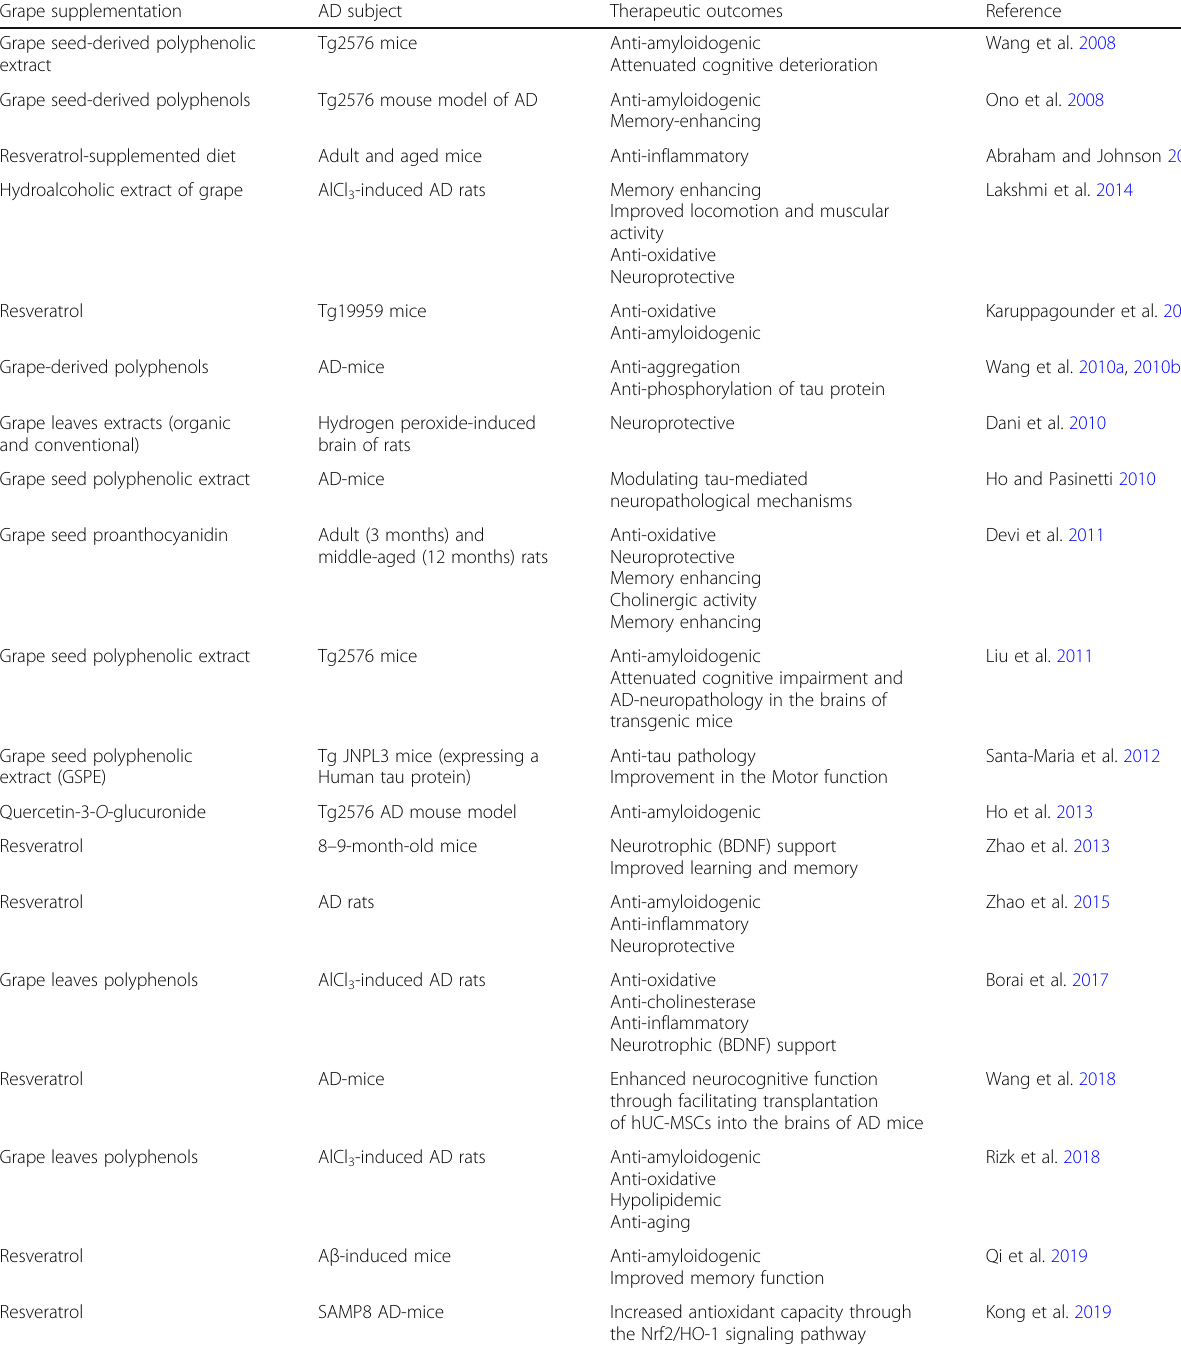
Table 1 The neuromodulatory role of grape-derived polyphenols in AD animal